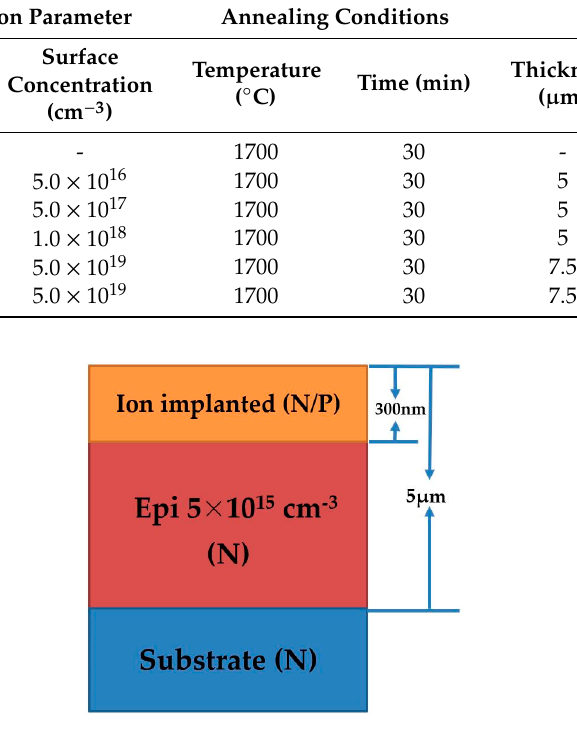
Figure 3. Schematic depth profile of 4H-SiC sample.